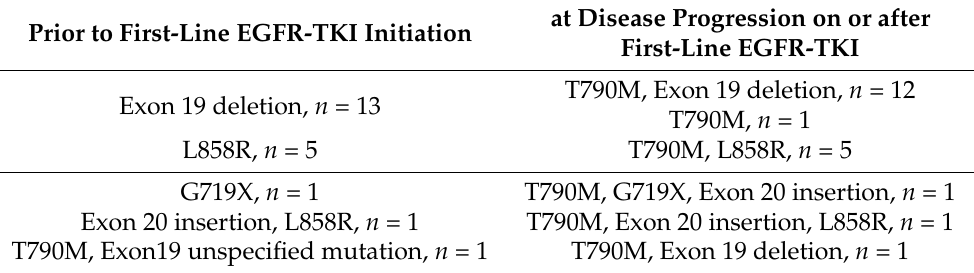
Table 4. EGFR mutation profile of T790M positive patients at the time of progression on or after first-line EGFR-TKI prior to first-line EGFR-TKI initiation and at disease progression on or after first-line EGFR-TKI